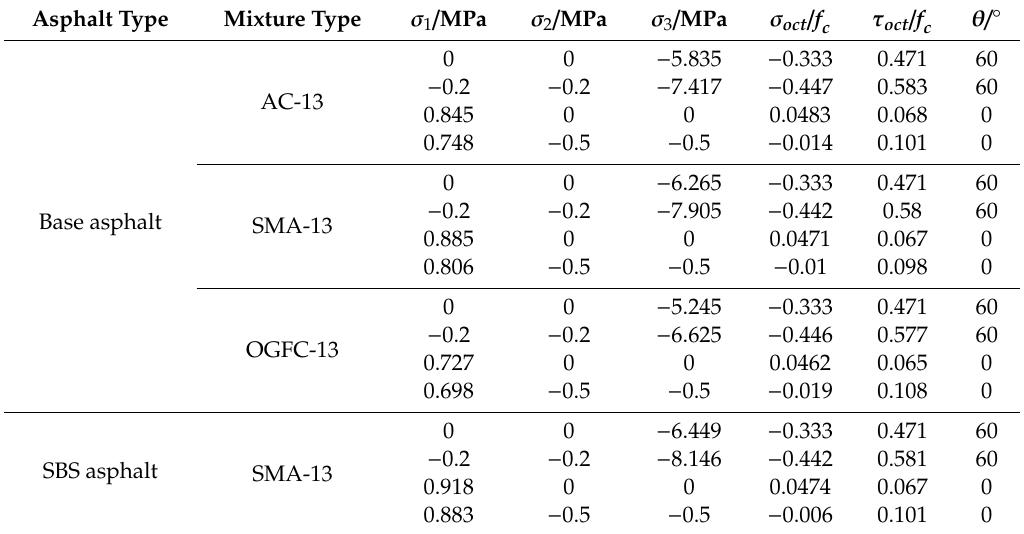
Table 4. Test results of three type of asphalt mixture under Marshall optimum oil-stone ratio.